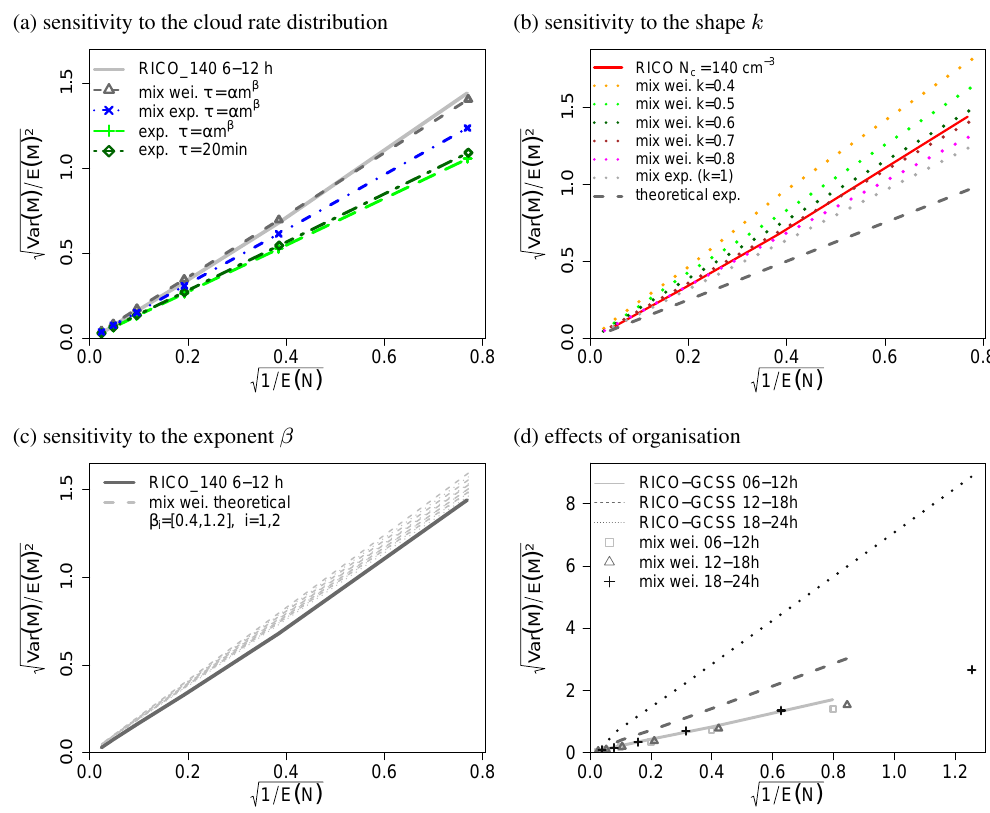
Figure 11. The variance of compound mass flux as a function of the inverse cloud number. Cloud lifecycles are explicit in all simulations and the time frame is 6–12h if not stated otherwise. The grid size is decreasing from the left (50km) to the right (1km) side of the graph.